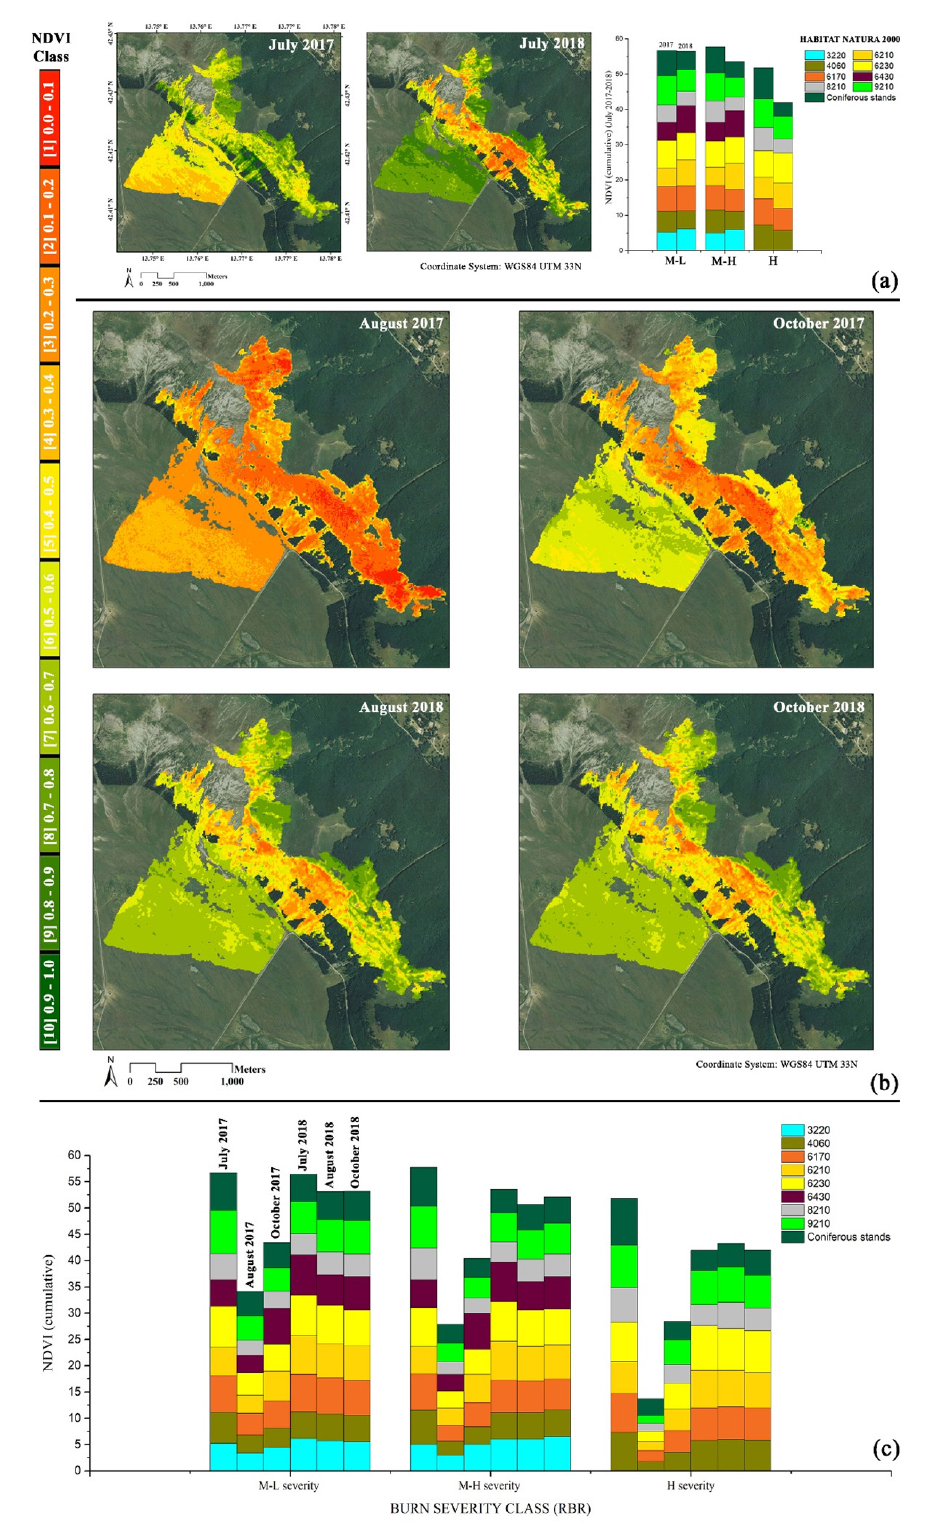
Figure 5. NDVI trends in the burned area and cumulative areas shared by habitats threatened by fire. (a) Monthly comparison in two years of monitoring (July 2017 and July 2018). (b) Comparison of NDVI discrete maps for the monitored months (August 2017, October 2017, August 2018 and October 2018). (c) NDVI average trends in all the monitored months, within the ‘burn severity’ classes (M-L= Moderate-Low severity; M-H = Moderate-High severity; H = High severity). The different colors of the cumulative columns represent the Annex I habitats threatened by fire in the study